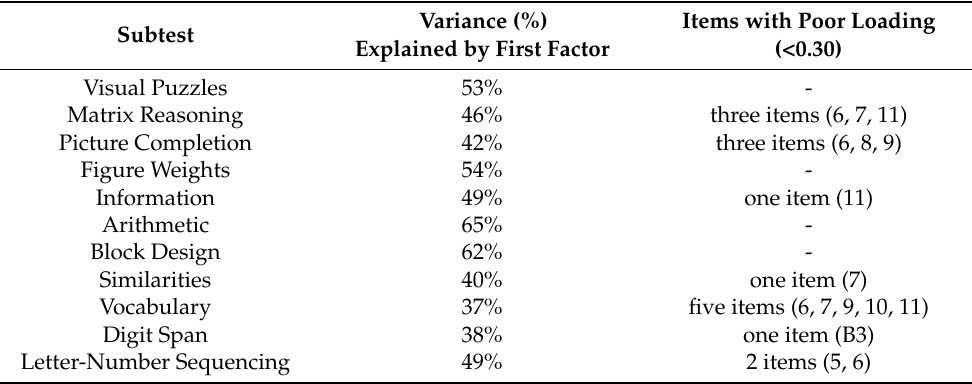
Table 2. Variance explained by the first factor and items with poor loading for each subtest of